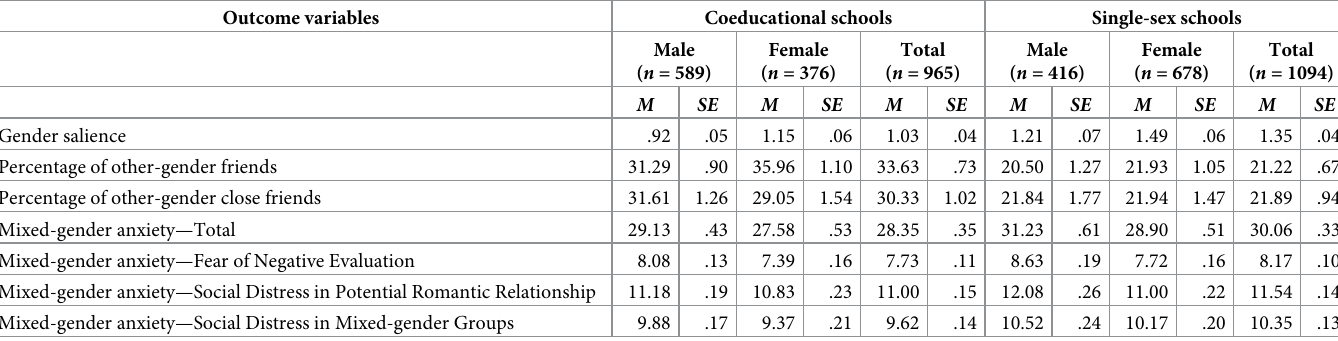
Table 4. Estimated marginal means and standard errors of the outcome variables (Study 1: High school sample). Outcome